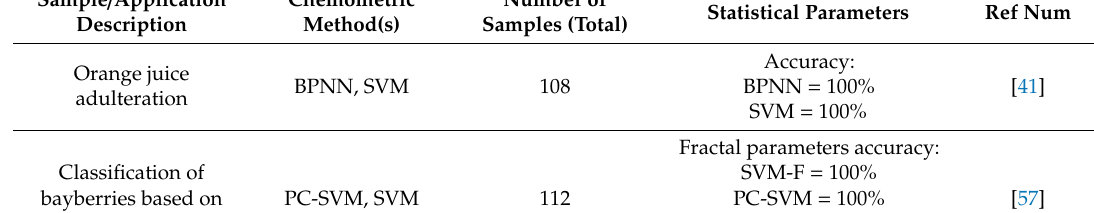
Table 2. Literature related to the use of chemometrics in classification of